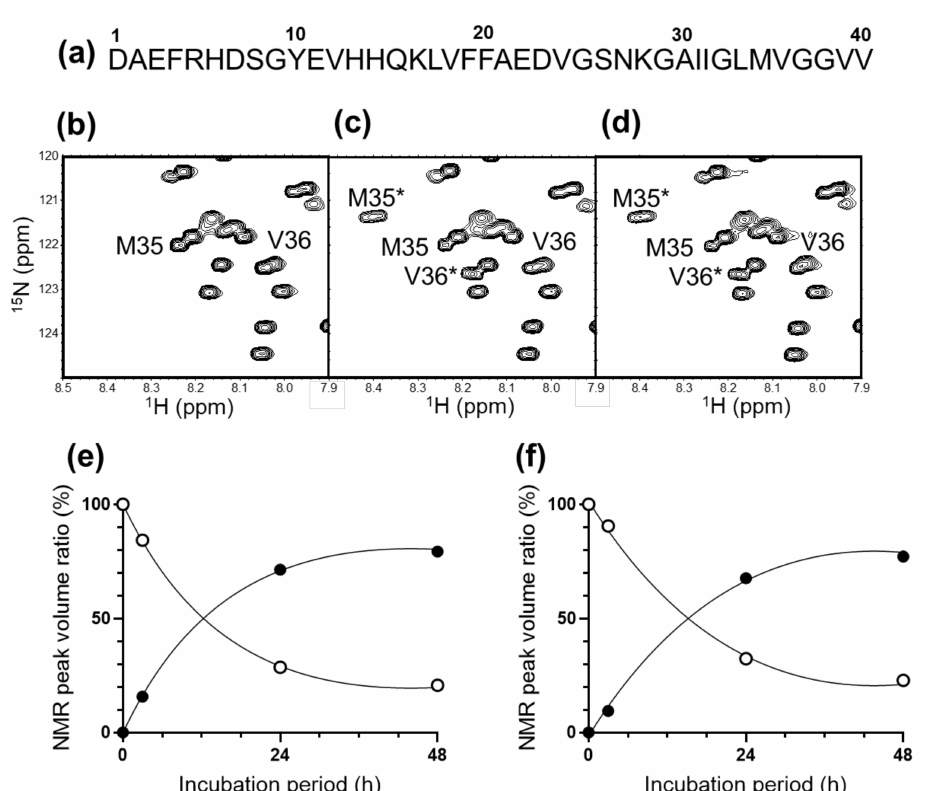
Figure 2. NMR spectral change of cold atmospheric plasma (CAP)-treated A β (1–40). ( a ) The primary structure of A β (1–40) peptide. ( b ) A portion of 1 H– 15 N heteronuclear single-quantum correlation (HSQC) spectra of A β (1–40) without irradiation. Portions of 1 H– 15 N HSQC spectra of A β (1–40) measured at 48 h ( c ) after a 10 s irradiation of CAP or ( d ) after dissolving into the 10 s pre-irradiated buffer solution. The time course of NMR peak volume ratio of Met35 ( 1 H 8.2 ppm, 15 N 122.0 ppm, open circle) and Met35* ( 1 H 8.4 ppm, 15 N 121.4 ppm, closed circle) of A β (1–40) ( e ) after the 10 s irradiation of CAP or ( f ) after dissolving into the pre-irradiated buffer